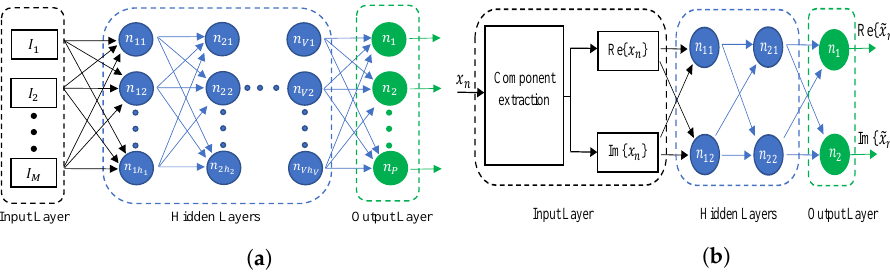
Figure 3. FFMLP neural networks: ( a ) general structure; and ( b ) OFDM signal processing.